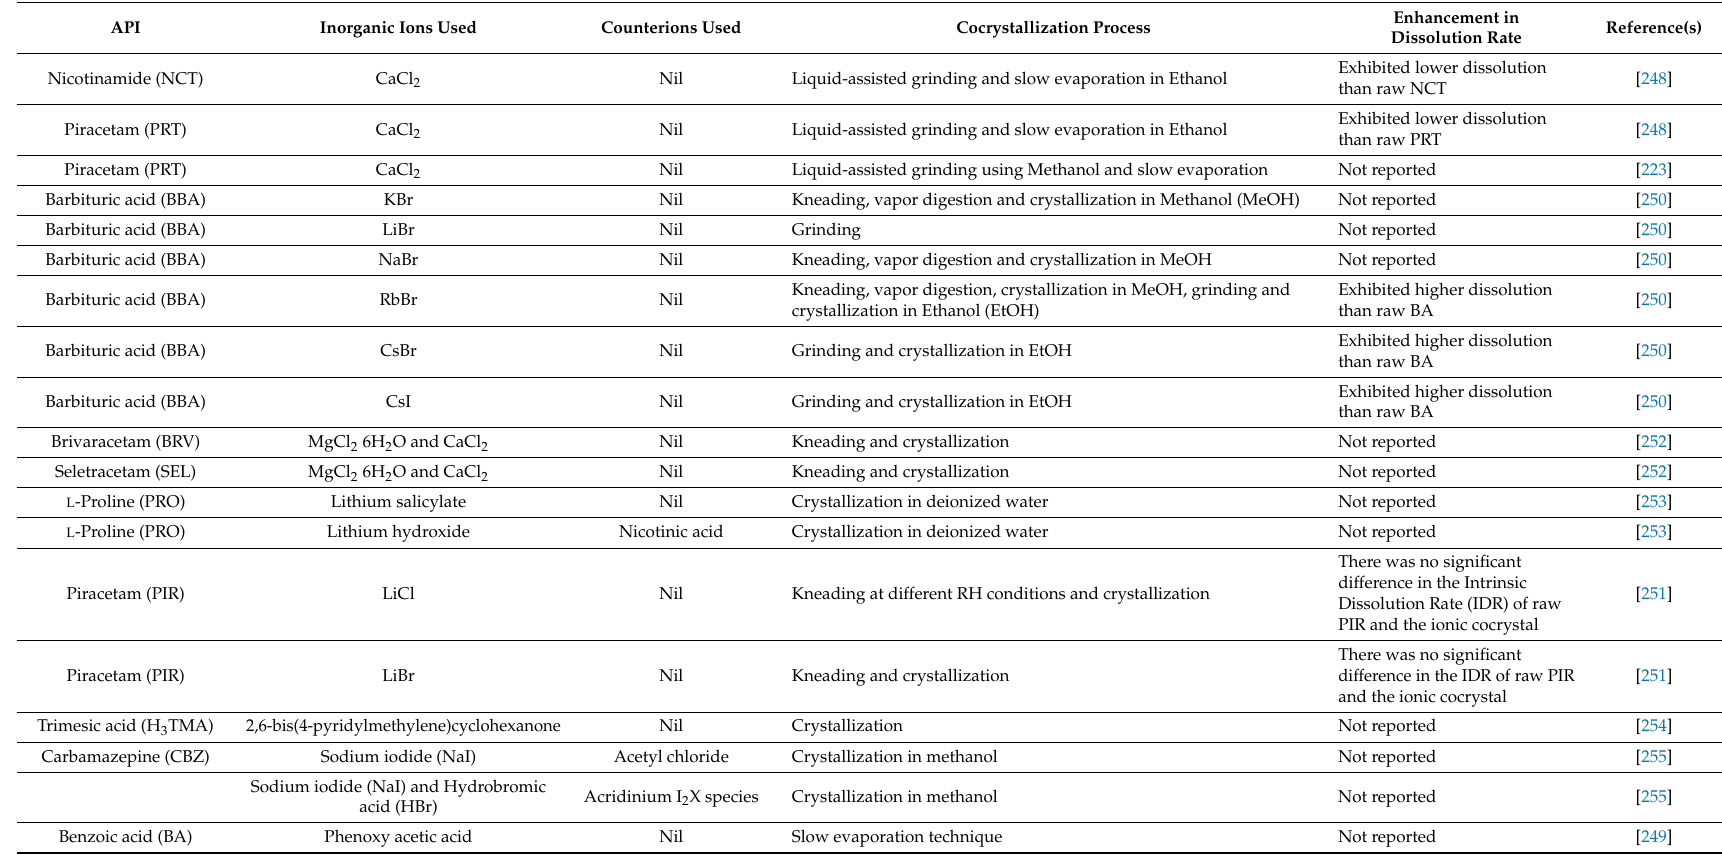
Table 10. Summary of reports on ionic cocrystals available in the